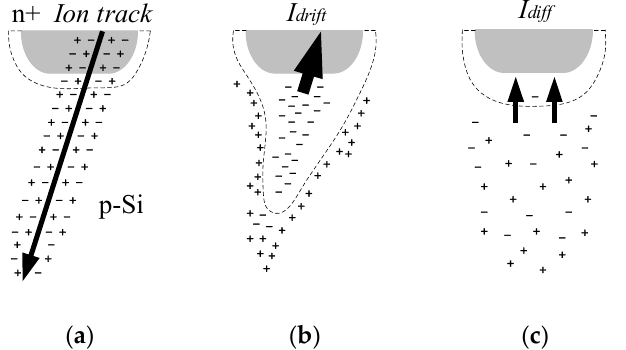
Figure 6. Three stages of injecting high-energy particles into sensitive nodes of transistors: ( a ) carrier generation; ( b ) carrier drift; ( c ) carrier diffusion.